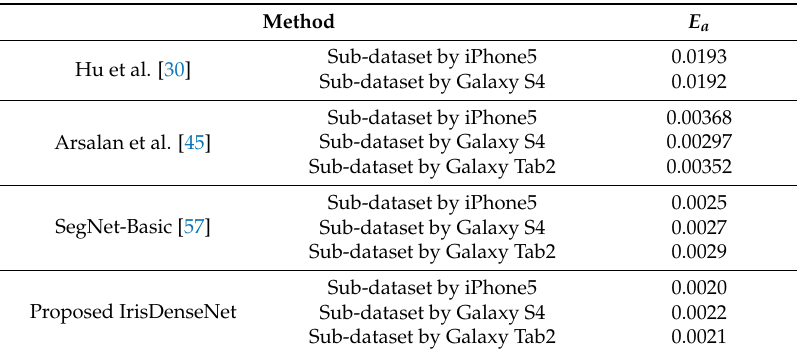
Table 6. Comparison of the proposed method with previous methods using CASIA v4.0 distance database based on NICE-I evaluation protocol.